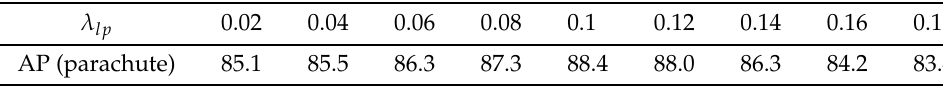
Table 6. Experimental results using different λ lp